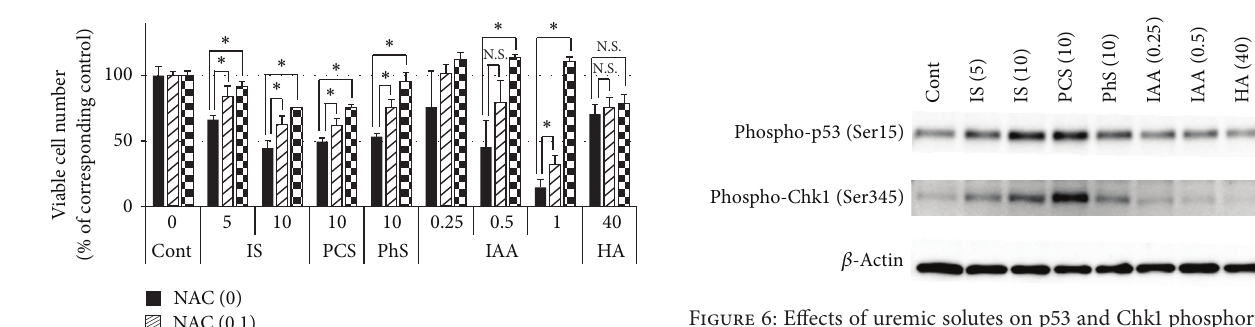
Figure 6: Effects of uremic solutes on p53 and Chk1 phosphoryla- tion. Porcine renal tubular cells were treated with each uremic solute for 5 hours. Cell lysates were obtained and subjected to Western blotting.Cont,control;IS,indoxylsulfate;PCS, p -cresylsulfate;PhS, phenyl sulfate; HA, hippuric acid; IAA, indoleacetic acid. Images are representative of two independent